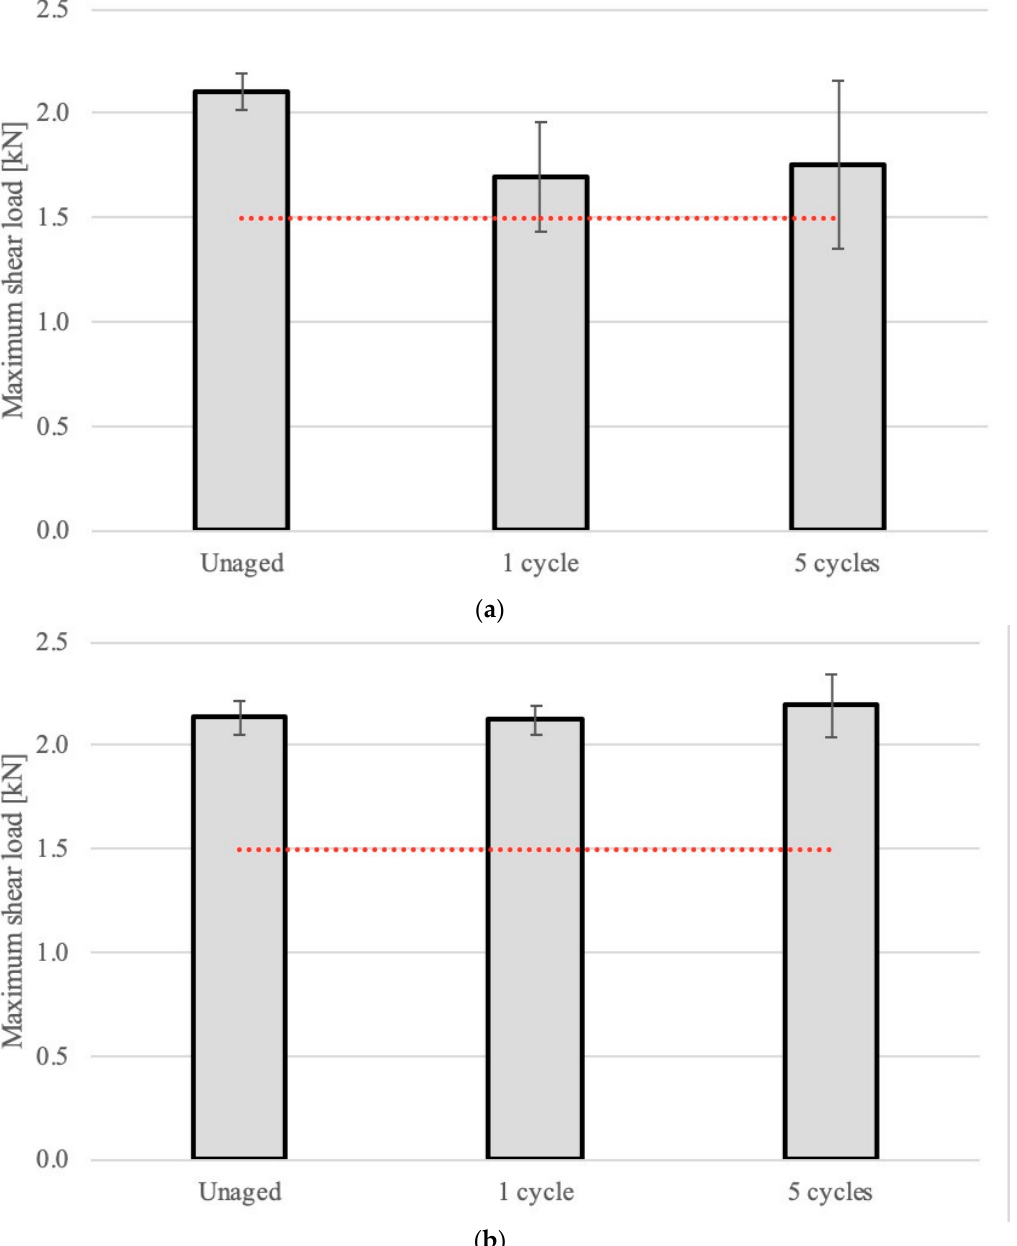
Figure 8. Maximum shear strength of RJS specimens, unaged and aged (in dielectric fluid) for the duration of one and five sharpening cycles. The red dotted line represents the threshold value for the RJS specimen’s minimum allowed joint strength (1.5 kN). ( a ) Aluminium RJS specimens. ( b ) Steel RJS specimens.